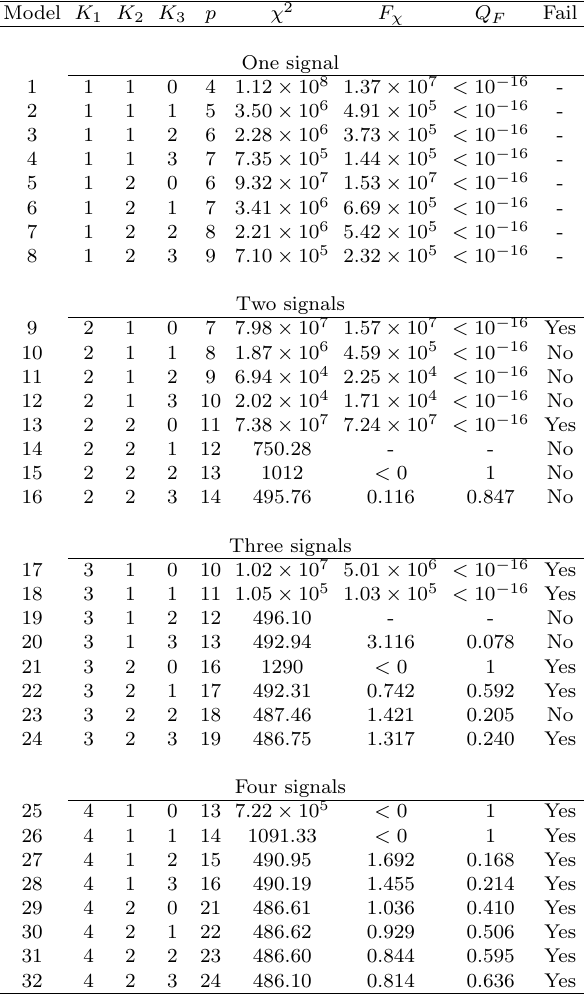
, K , K 1 2 3 (Eq. 14). F